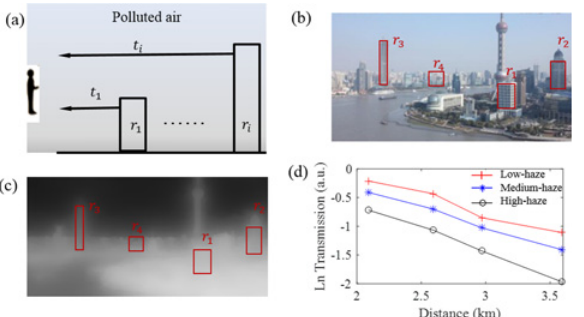
Fig 5. The transmission decreases as the distance or PM 2.5 index increases. (a) Schematic illustration of transmission variation with distance. (b) Four ROIs (r 1 ~r 4 ) located at increasing distances. (c) The estimated transmission map. (d) Semi-logarithmic plots of transmission curves vs. distance under different haze